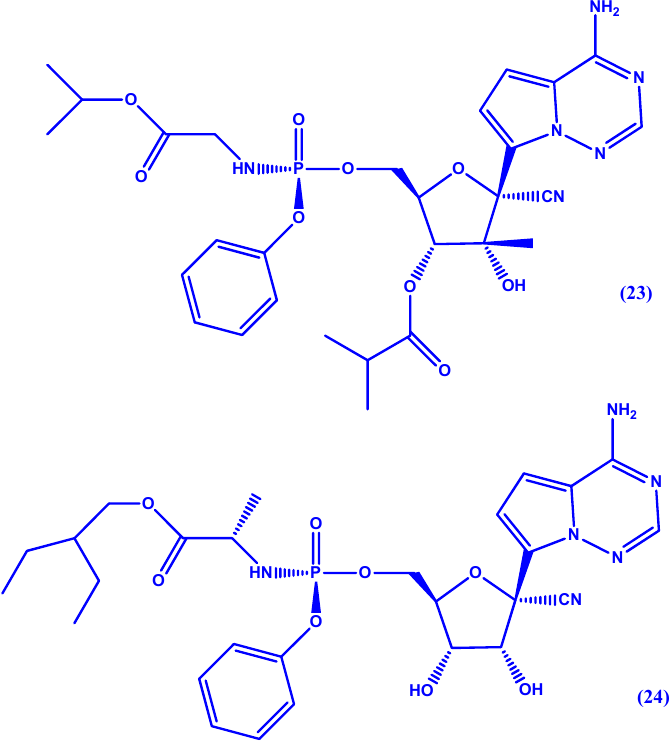
Figure 12. Chemical structure of GS-6620 ( 23 ) and GS-5734 ( 24 ).